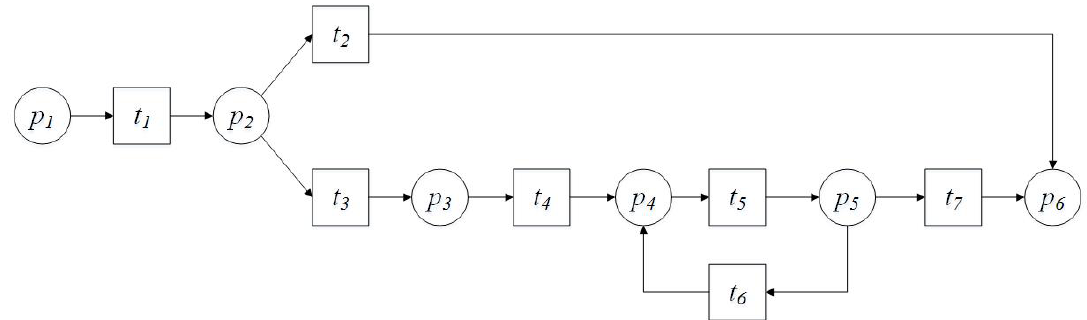
Figure 4. WF-net model of repair process. t 1 : customer service center receives the telephone repair; t 2 :